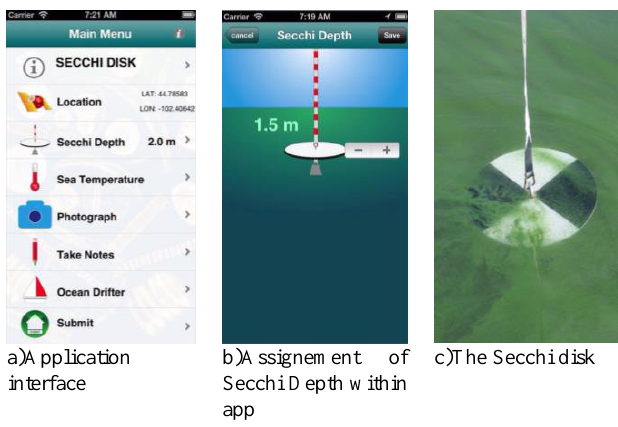
Figure 5: The data acquisition schema of HydroColor (Source: (Leeuw & Boss, 2018) )